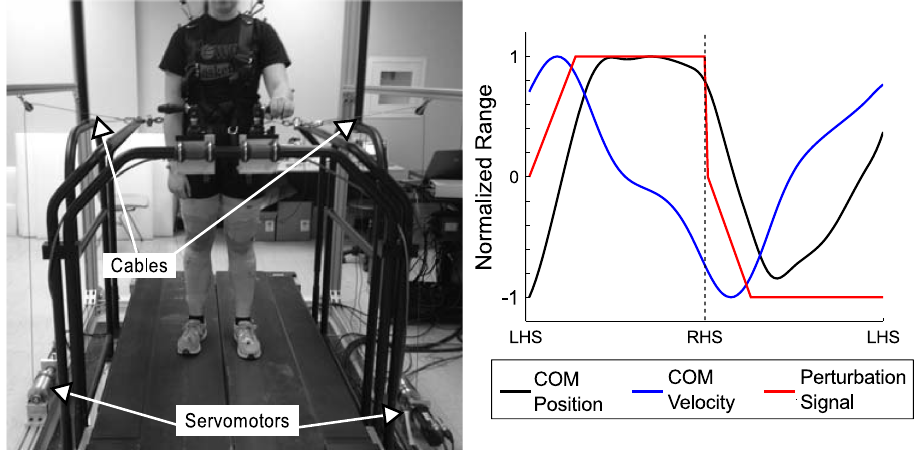
Fig 1. Experimental setup. Participants walked on a split-belt treadmill at their self-selected speed (belts tied at the same speed). Two servomotor systems were used to drive a cable spool, with the cables connected to the waist belt on the fall arrest harness. An example perturbation timing for a subject is displayed along with the COM position and velocity for that cycle. Perturbation timings were based upon time between successive heel strike events, with perturbation magnitude determined by the participant’s body